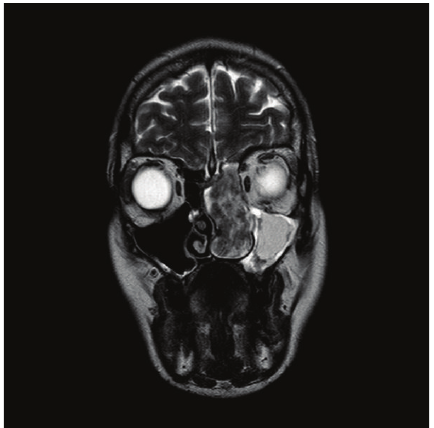
Figure 5: MRI (coronal, T2